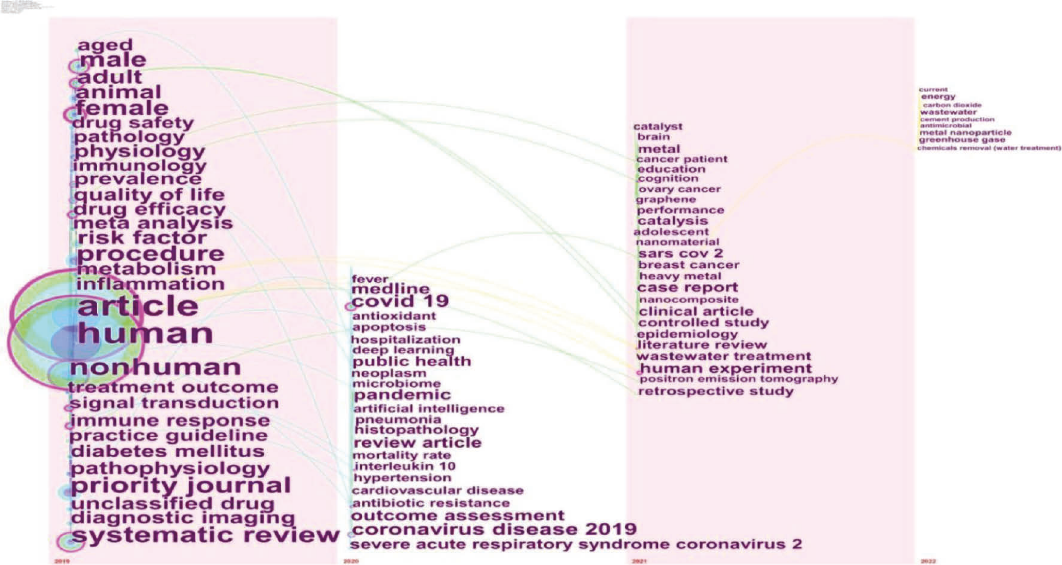
Figure 37: Timeline of the keyword co-occurrence network: 2019–2022 for review articles.